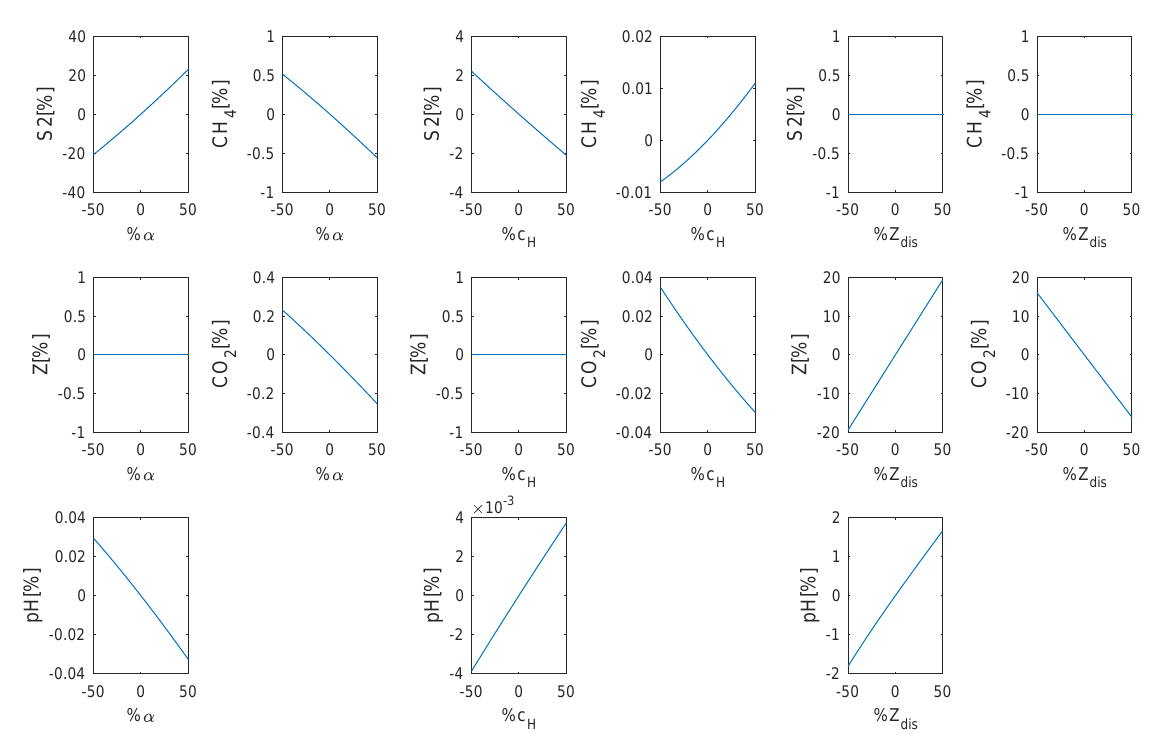
Figure 8: The results of the sensitivity analysis for α , the Hashimoto factor and alkalinity